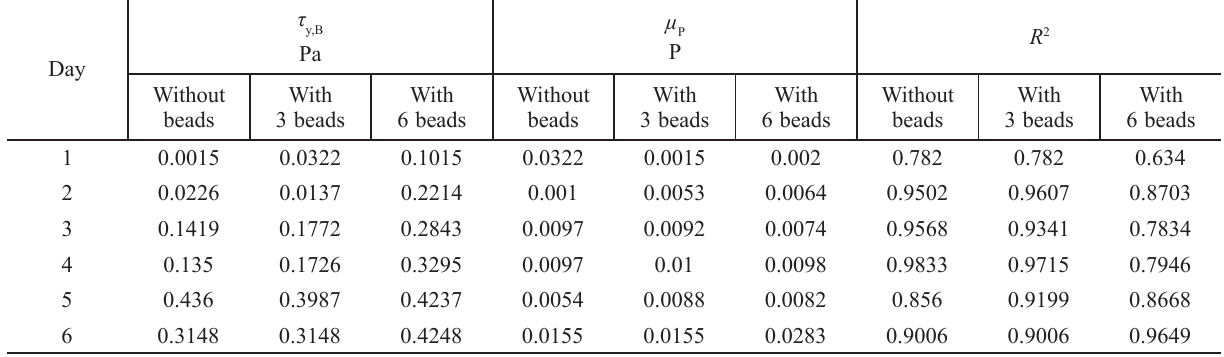
Table 1 – Bingham model parameters for cell grown without beads, with 3 beads, and 6 beads